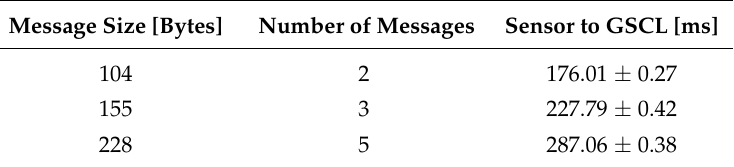
Figure 9. Experimental setup in the laboratory testbed. Table 6. Event notification